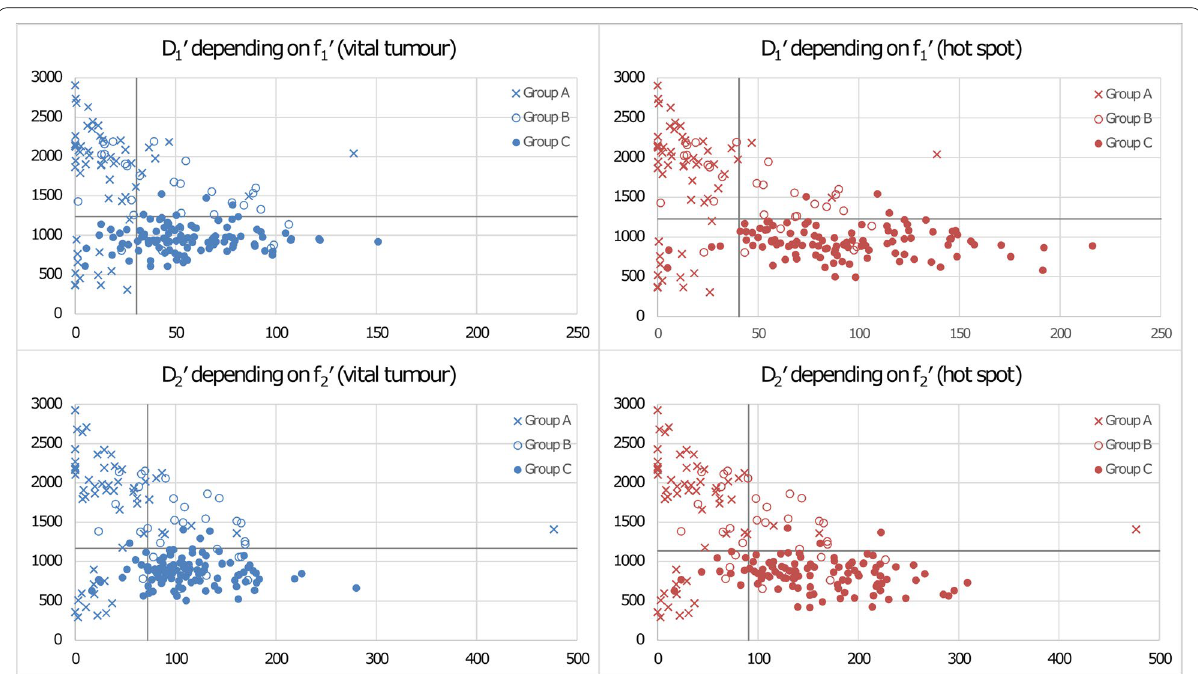
Fig. 3 Overview to combined use of D 1 ′ and f 1 ′ as well as D 2 ′ and f 2 ′ parameters. On the ordinate axis D 1 ′ respectively D 2 ′ is given (in units of 10 -6 mm 2 /s), on the abscissa axis f 1 ′ respectively f 2 ′ (in units of 10 -3 ). Blue data points (left diagrams) belong to vital tumour regions of interest (VT-ROIs), red (right diagrams) to hot spot ROIs (HS-ROIs). For each parameter, the cutoff point (see Table 5) is also given (grey lines). It is obvious that differentiation between benign lesions (group A B) and malignant lesions (group C) is comparable for D 1 ′ and D 2 ′ and for VT-ROIs and HS-ROIs. + However, in the case of HS-ROIs, the differentiation improves clearly, if f 1 ′ respectively f 2 ′ is used together with D 1 ′ respectively D 2 ′ (lesions in the quadrant bottom right were assigned as malignant, all other lesions as benign), especially for combination D 1 ′ f 1 ′ with 93.7% correctly identified + cases instead of 88.0% (see Table